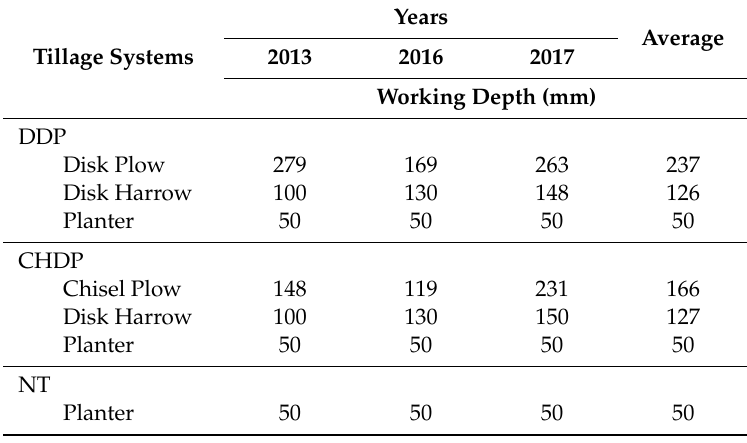
Table 5. Working depth of the implements for each tillage